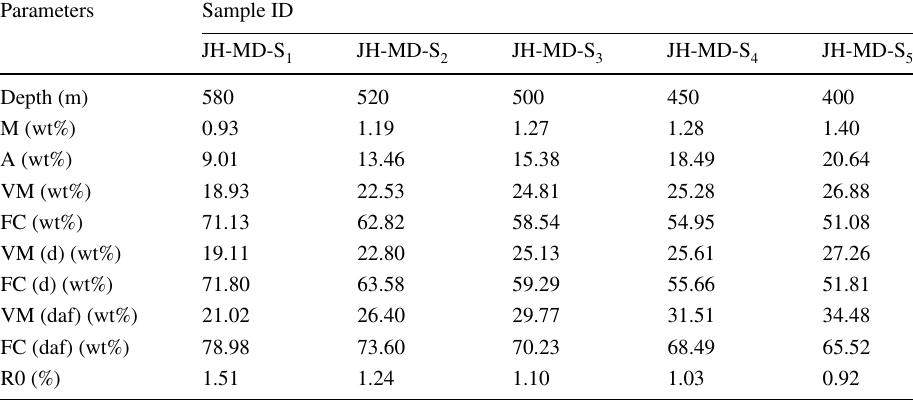
Table 1 Results of proximate analysis of coal samples